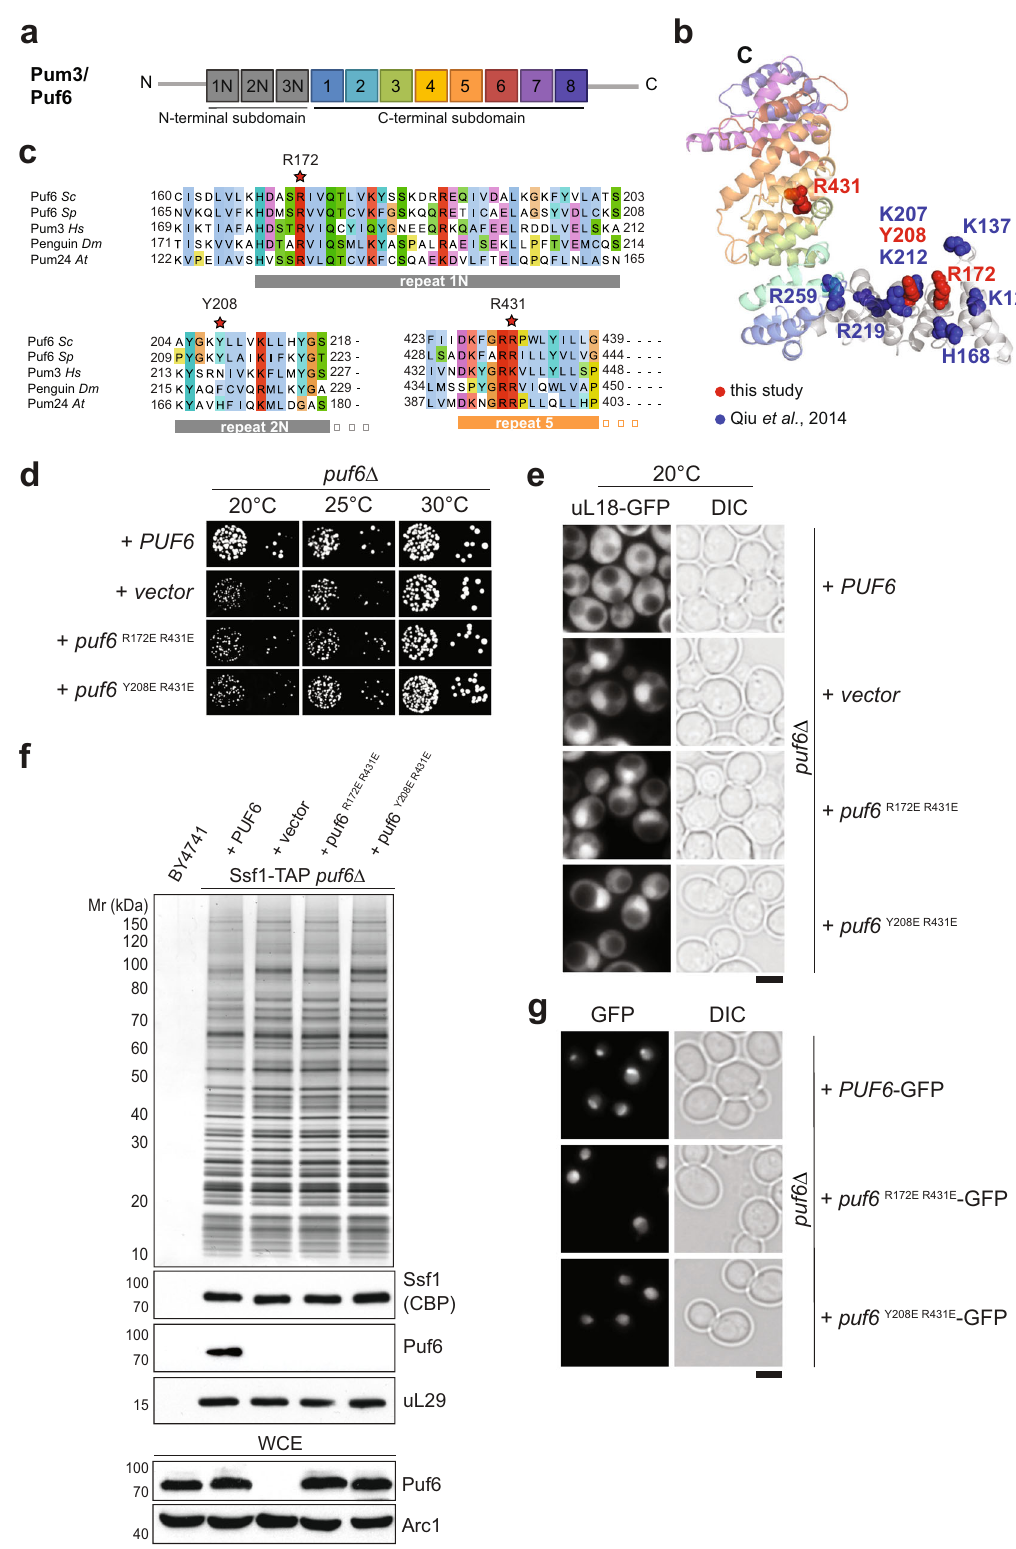
(Fig. 3c). Puf6 co-enriches mainly with the nucleolar Ssf1-TAP, but lower levels of Puf6 were detected on the nucleoplasmic Rix1-TAP particle (Fig. 3c). On the other hand, Nog2 is not found on the Ssf1-TAP but co-enriched only with the Rix1-TAP particle. Nog2 is hardly detected on the export competent Arx1- TAP particle (Fig. 3c). Further, we found that Nog2-TAP